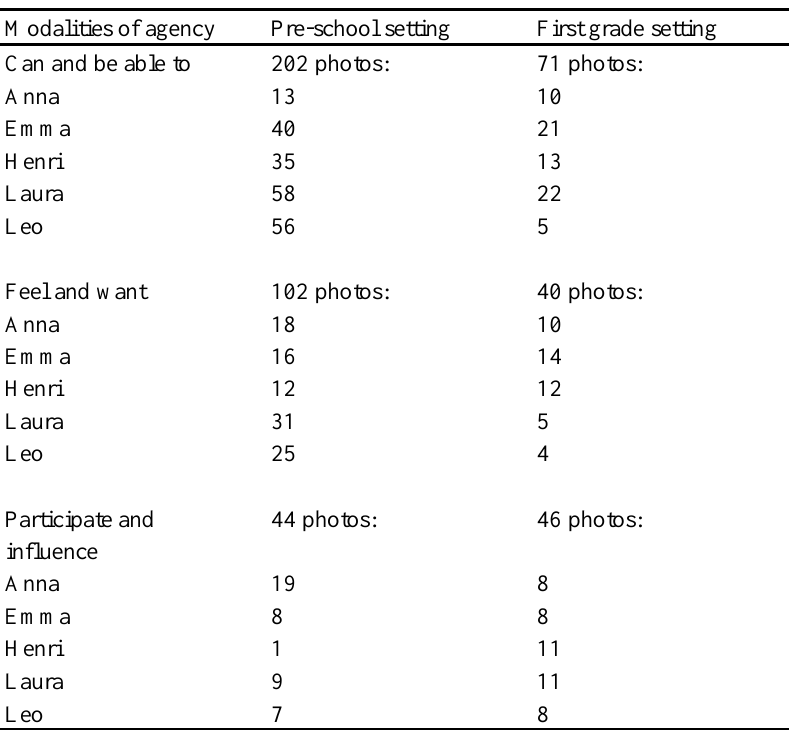
The children’s photos in the preschool and first grade settings Modalities of agency Pre-school setting First grade